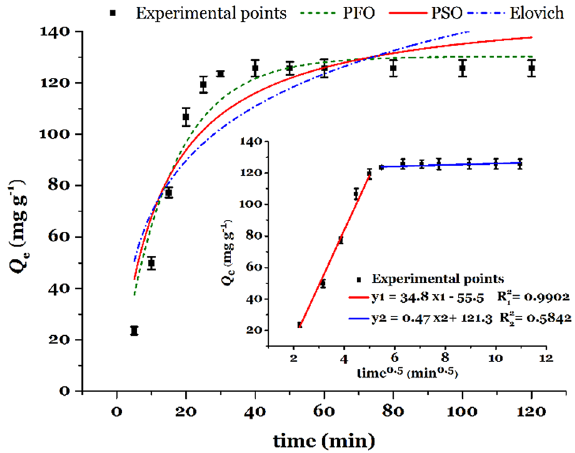
Figure 9. The effect of contact time on the adsorption performance of TSF-KCC-1 for Hg(II) removal and non- linear fitting of three different kinetic models (PFO, PSO, and Elovich). The inset is the IPD